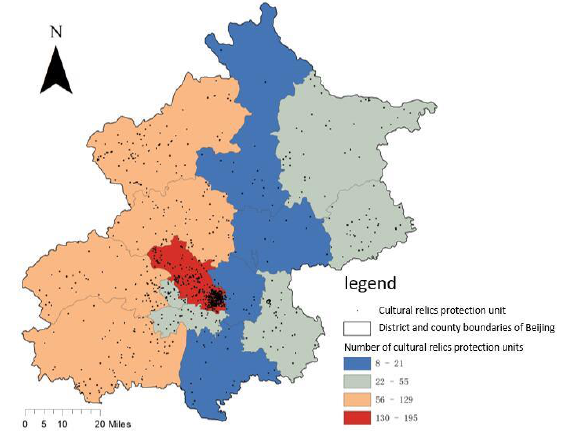
Figure 1 . Spatial distribution of cultural preservation units in Beijing.